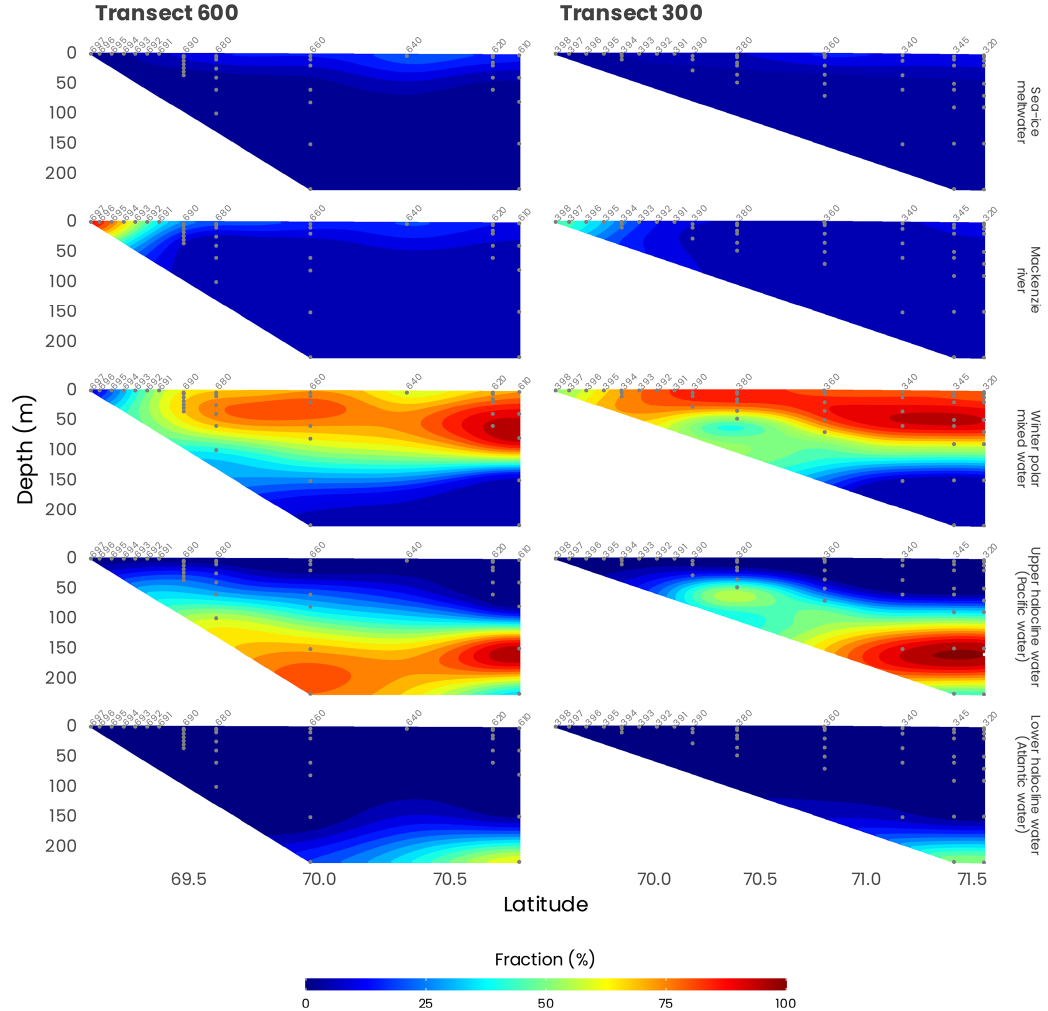
Figure 4. Distribution of source water types along transects 600 and 300 (see Fig. 1). Station numbers are identified in light gray on top of each